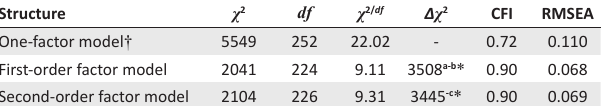
TABLE 4: Comparison of a priori Psychological Capital Questionnaire factor structure (original factor structure). Structure